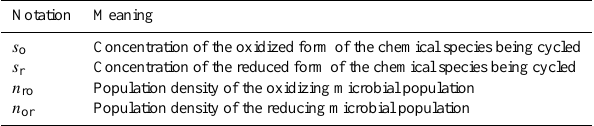
Table 1. Description of the notation used in the